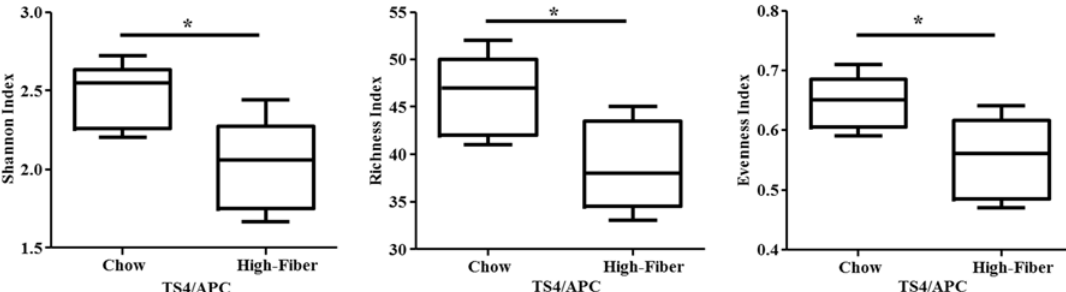
Figure 3. Alpha diversity is significantly lower in TS4/APC high fiber-fed mice compared to chow-fed mice. Plots show the Shannon ( p = 0.023), Richness ( p = 0.033), and Evenness ( p = 0.033) values between mice groups at the genus level. Two-tailed unpaired Independent t -test was used to analyze differences for parametric data satisfying test assumptions.